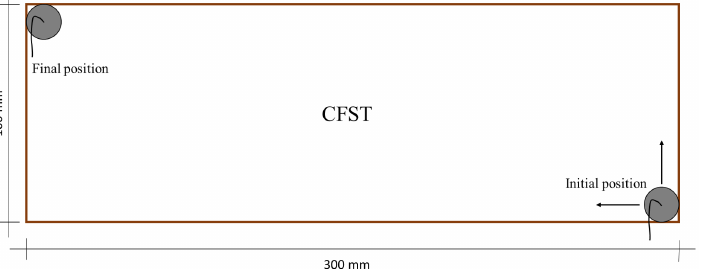
Figure 3. Schematic path of transducers during the scanning process. The gray circles represent the diameter of the transducers. The arrows show the directions of movement of the